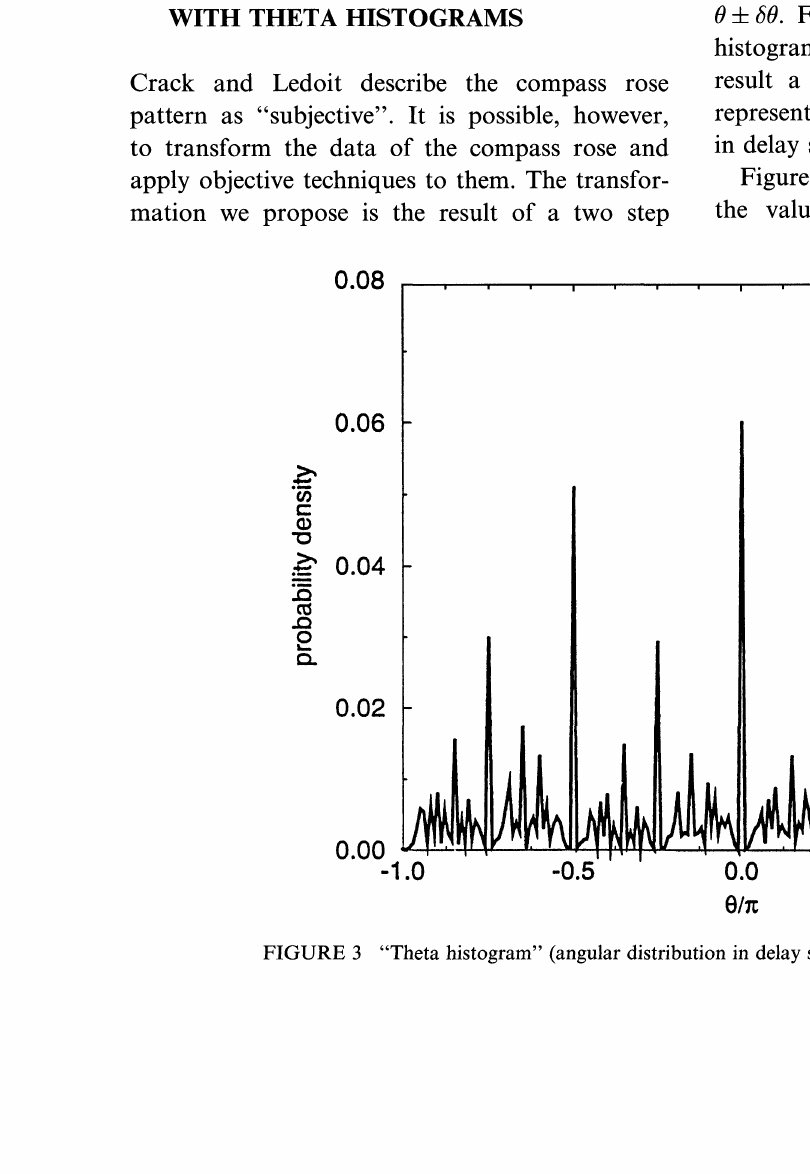
FIGURE 3 "Theta histogram" (angular distribution in delay space) of Weyerhauser stock